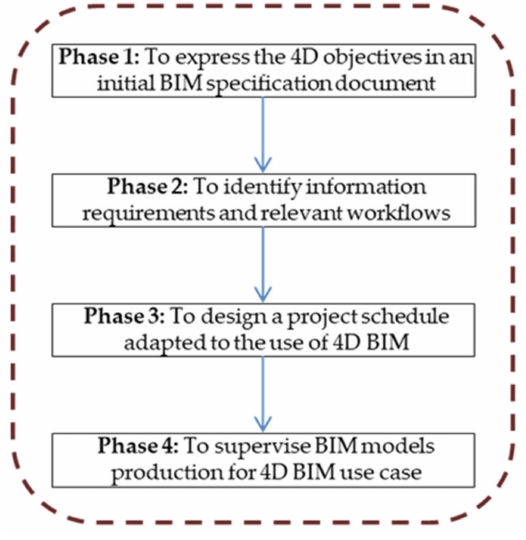
Figure 3. The CESI 4DBIM